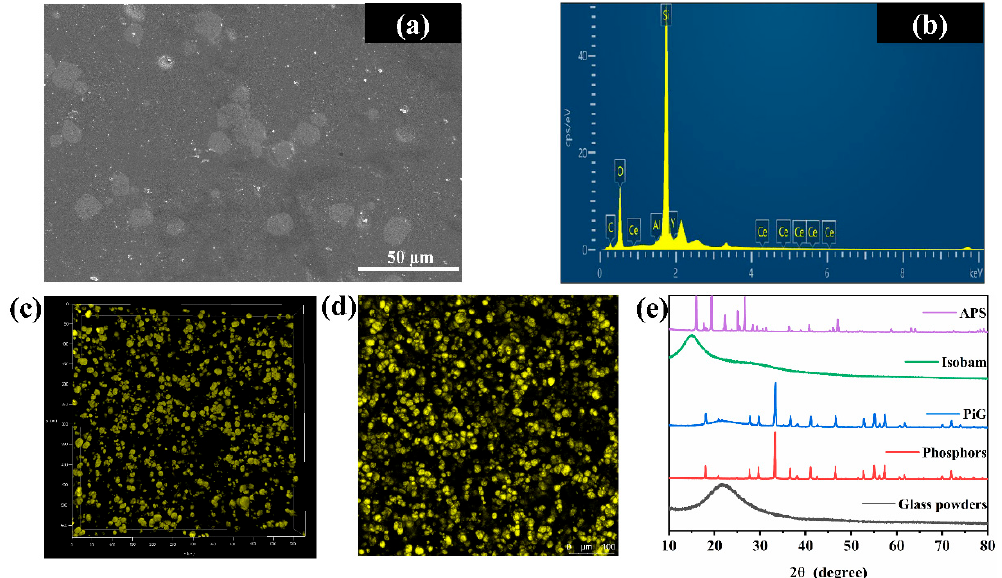
Figure 5. ( a ) SEM image and ( b ) EDS analysis of polished surface of 72 wt.% PiGs; ( c , d ) 3D reconstruction and surface CLSM images of 72 wt.% PiGs; ( e ) XRD patterns of APS, Isobam, PiGs, phosphors and glass powders.